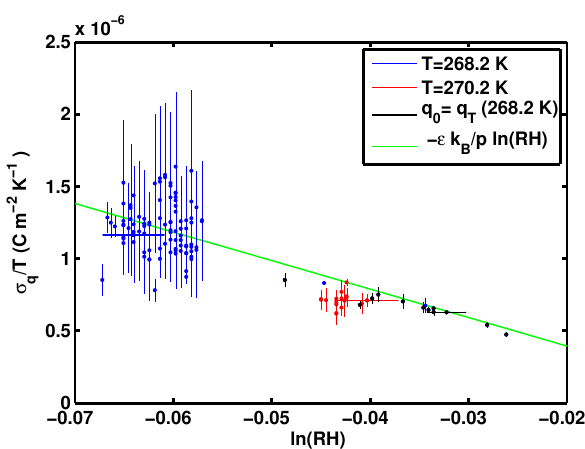
Fig. 5. Surface charge density divided by temperature versus logarithm of relative humidity, for all equilibrated droplets. The vertical lines are error bars showing the instrumental uncertainty, including uncertainty on charge and droplet diameter of each measurement. Blue data: each point represents a droplet equilibrated around 268.2K. Red data: droplets equilibrated around 270.2K. Black data: a few droplets at 268.2K that were not loosing charge during the experiment, hence the surface charge density is less uncertain in these measurements. The green line shows the theoretical relation between relative humidity and surface charge. Horizontal bars approximate the experimental error on the relative humidity estimated from the slope of the evaporation curves (Fig.